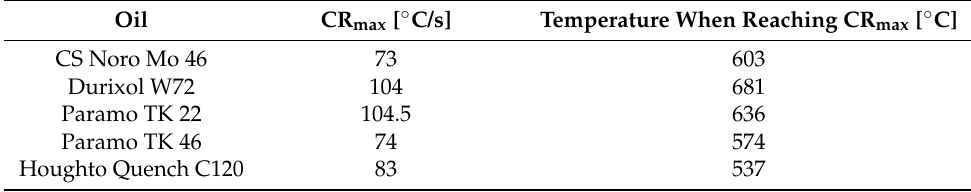
Table 3. Basic parameters derived from the cooling curve.